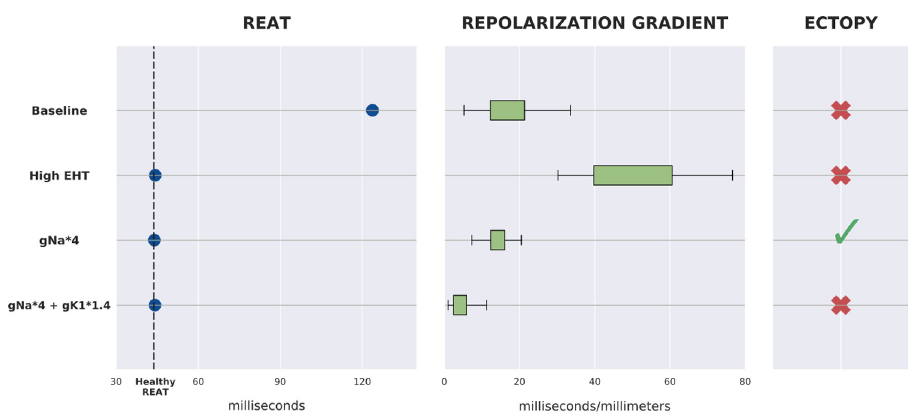
Fig 8. Summary of the 4 cases tested for arrhythmic behavior. For the Baseline and High EHT cases, EHT c is set to 0.112 S/m (mid value in experimental range) and 1.008 S/m, respectively, and no modifications to ion channels’ densities are made. When the density of the ion channels responsible for the fast Sodium current and the inward rectifier potassium current are increased, the EHT c is set to 0.112 S/m.The left panel shows which cases match estimated healthy REATs. The center panel shows the distribution of the mean repolarization gradients at the interface between myocardium and EHT (on 100 beats pacing protocol). The right panel shows the presence or absence of ectopic beats fired from the